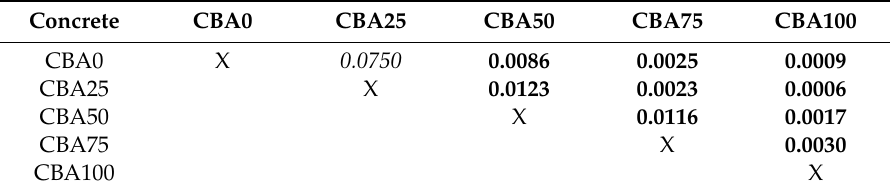
Note: The LCAs were evaluated with the six ReCiPe2016 single score options (I / A, H / A, E / A, I / I, H / H, and E / E). The p -values were evaluated according to three-valued logic: Bold font—appears to be positive, ordinary font—appears to be negative, and italic font - judgment is